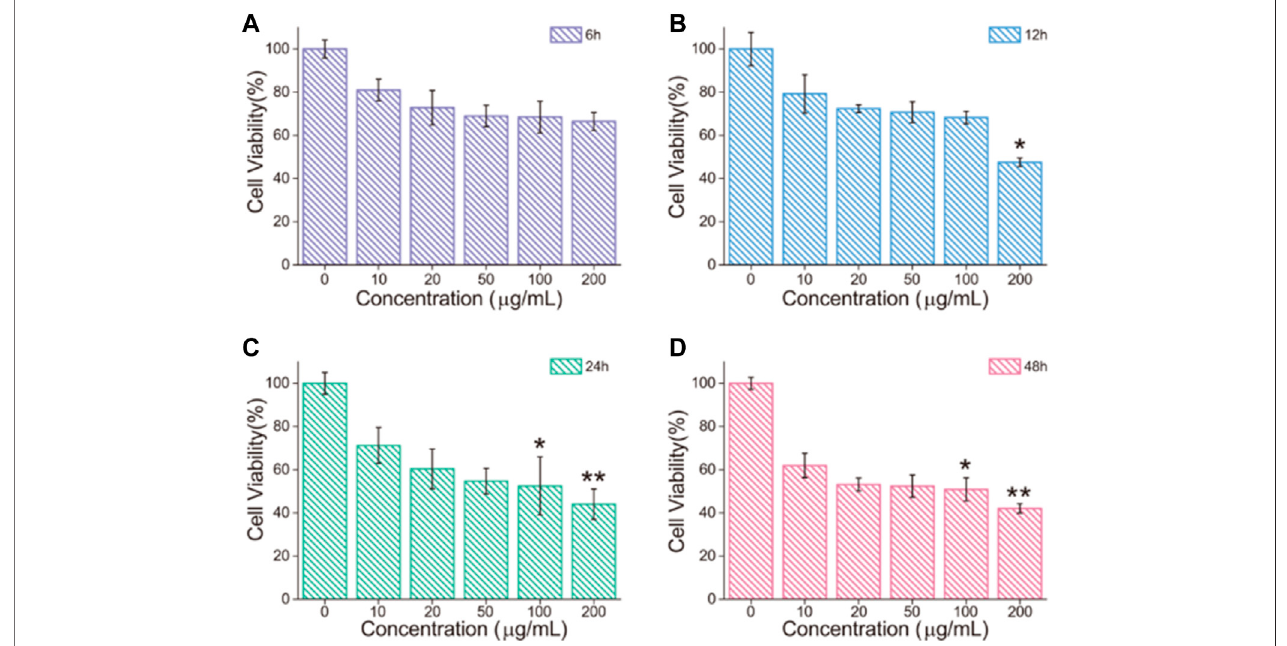
FIGURE 5 | (A – D) HBE cell viability after treatment with different concentrations of Fe 3 O 4 /GO for 6, 12, 24 and 48 h, respectively, (* p < 0.05, ** p < 0.01, *** p < 0.001).